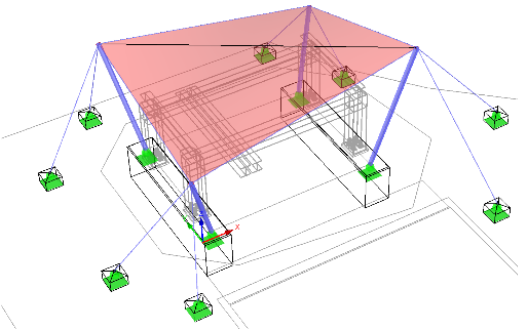
Figure 3. Initial model and location of supports [30].